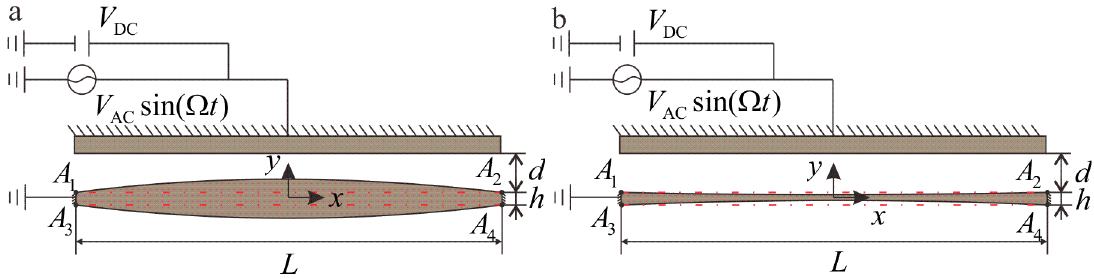
Figure 1. Schematic of an electrically-actuated microbeam. ( a ) λ > 0 case. ( b ) λ < 0 case. The dotted line in red is the ideal section location of the beam.